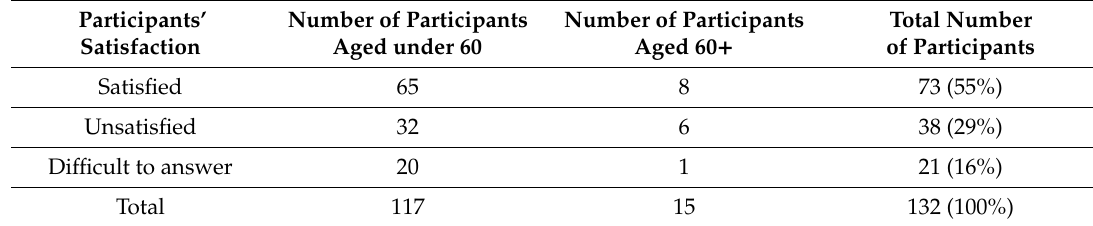
Table 6. Participants’ satisfaction with their current